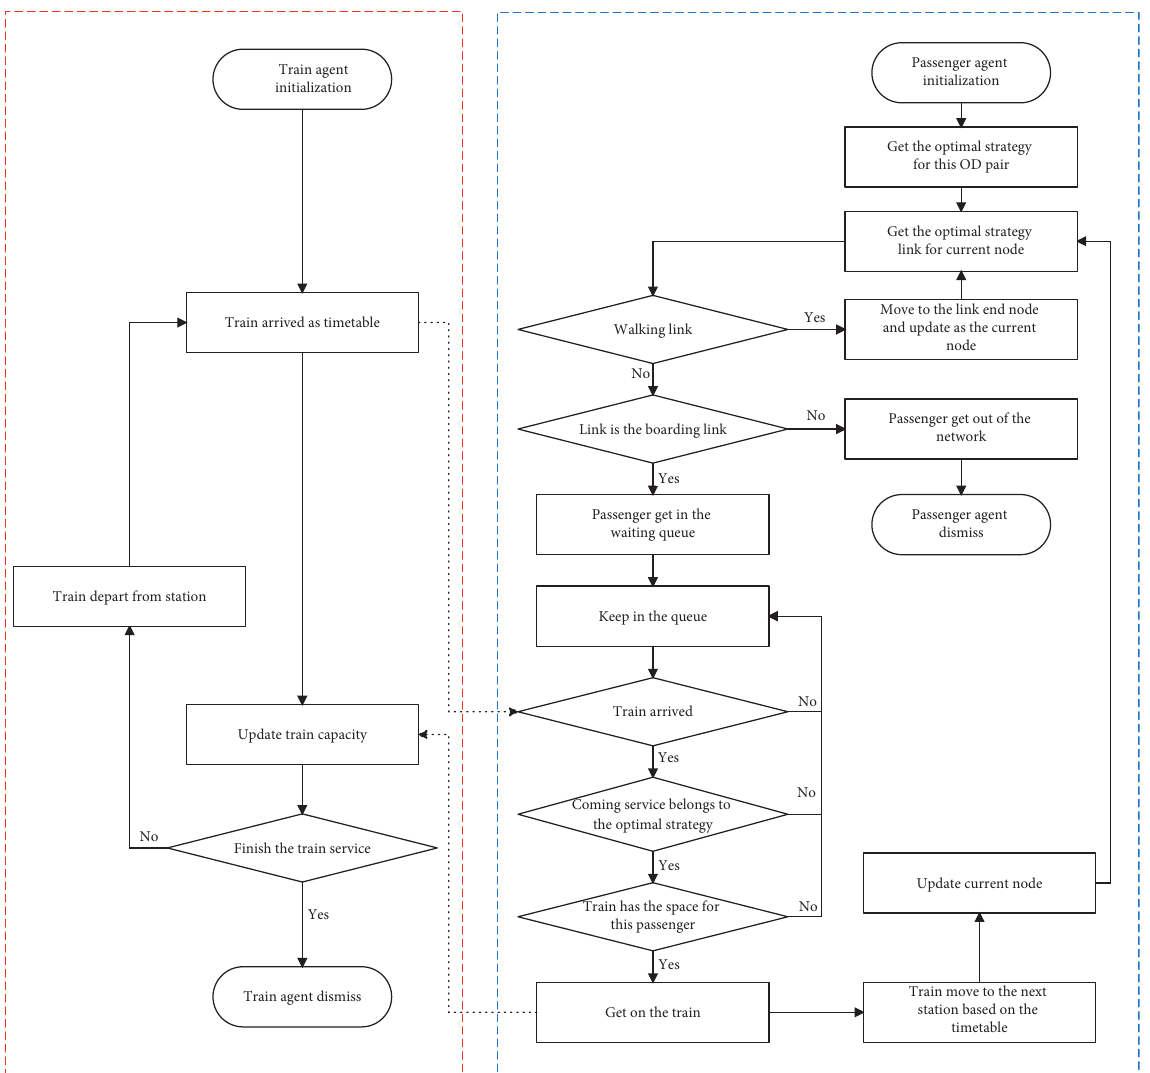
Figure 3: Interaction between passenger and vehicle agent.